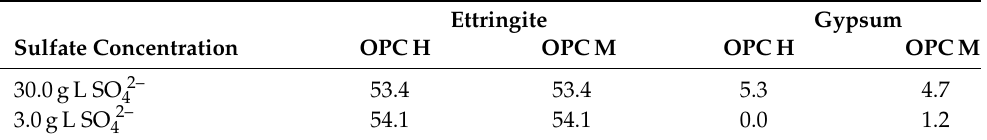
Table 2. Thermodynamic estimation of the maximum crystallisation pressure [MPa] for the formation of ettringite and gypsum in hardened cement paste exposed to sodium sulphate solution. Ettringite Gypsum Sulfate Concentration OPC H OPC M OPC H OPC